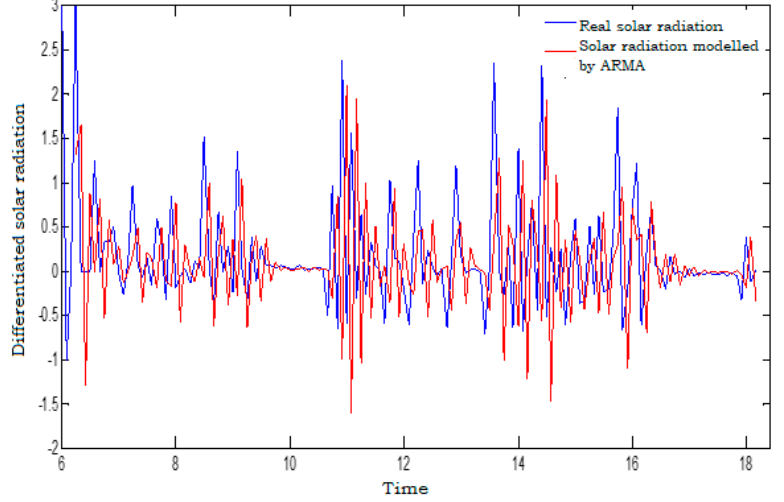
Figure 10. Solar radiation evolution modeled by ARMA (3,3) for a summer day.